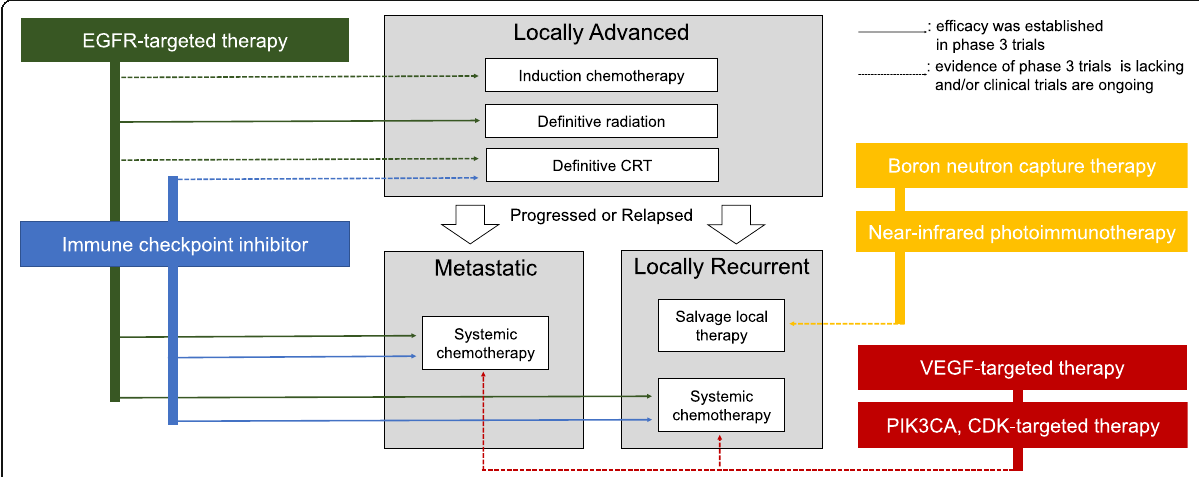
Fig. 2 Landscape of non-surgical treatment strategy for SCCHN. In locally advanced patients, multimodal therapy including radiation and systemic chemotherapy are the standard regimen. Clinical evidence of molecular targeted drugs to these patients is limited yet. In progressed and/or relapsed setting, on the other hand, systemic chemotherapy is the standard and there are newly approved or investigating molecular targeted drugs. Some recurrent patients have locally recurrent diseases, to whom new local treatments have been